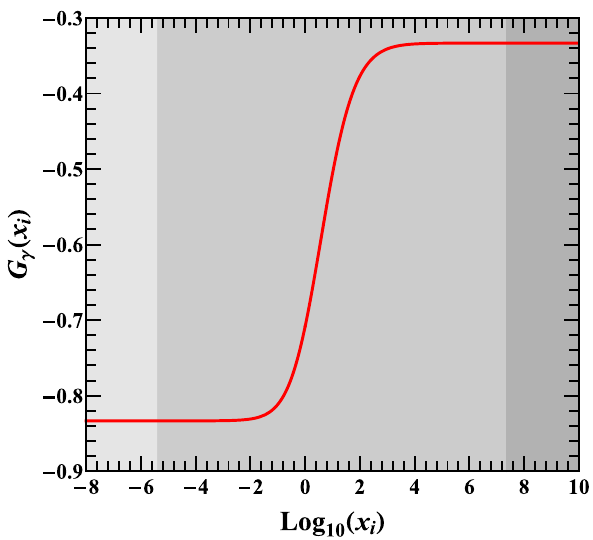
(cid:24) (cid:25) x evolving i (cid:2) 4 . 0 × 10 − 6 ) and dark gray (cid:24) (cid:25) i = − 5 / 6 and x γ i